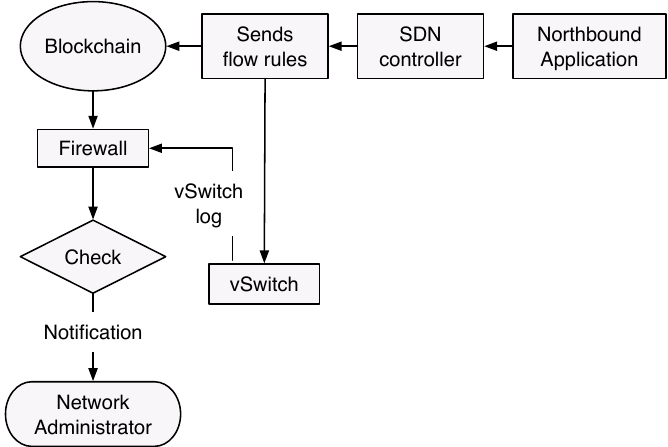
Figure 5. Flowchart execution of blockchain-based integrity checking system